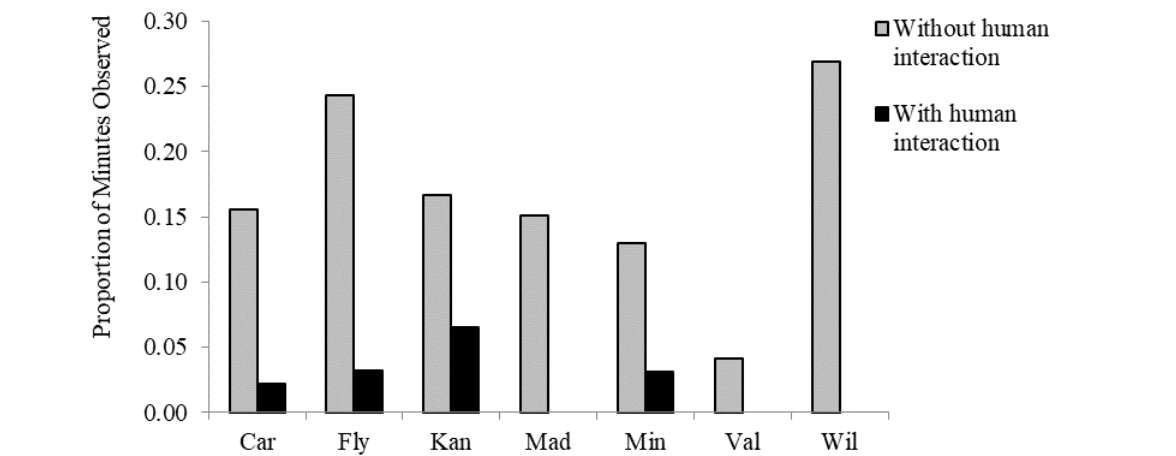
Prevalence of Feeding Behavior with and without Human Interaction